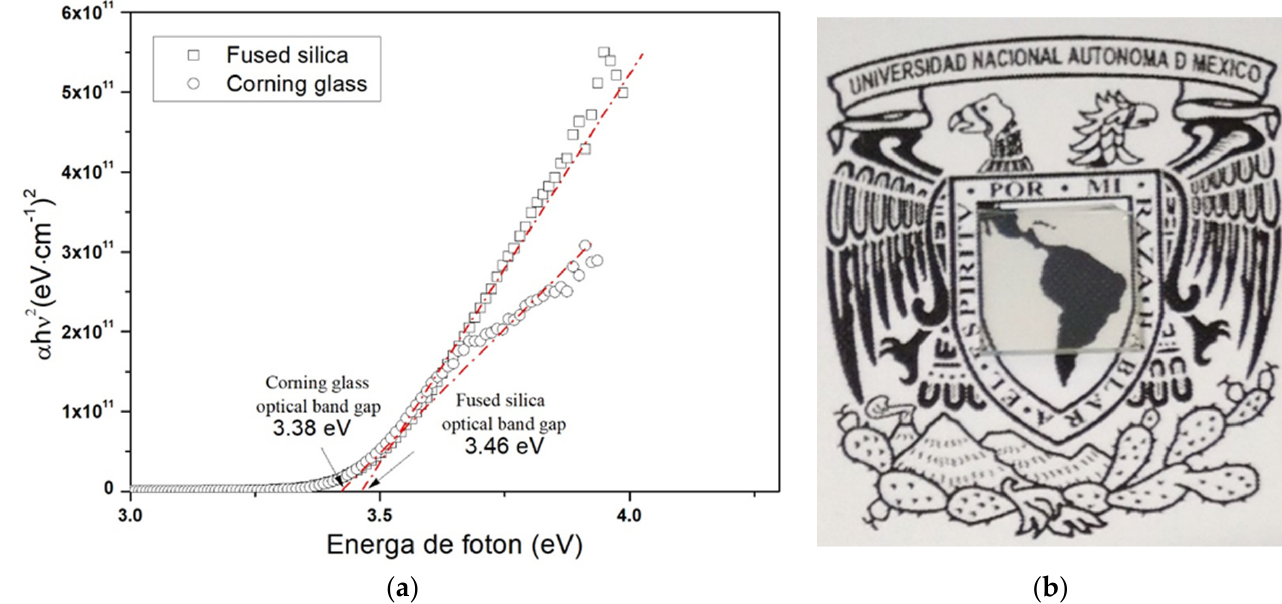
Figure 4. ( a ) Tauc scattering of direct transitions for ZnO:Al deposited on fused silica substrate (squares) and glass substrate (circles). Linear fit extrapolation was taken over a range of 3.4 to 4 eV in both cases and is presented by a red dotted line. See text for details. ( b ) Photograph of ZnO:Al film deposited on glass substrate showing exceptionally good homogeneity at the macroscopic level.